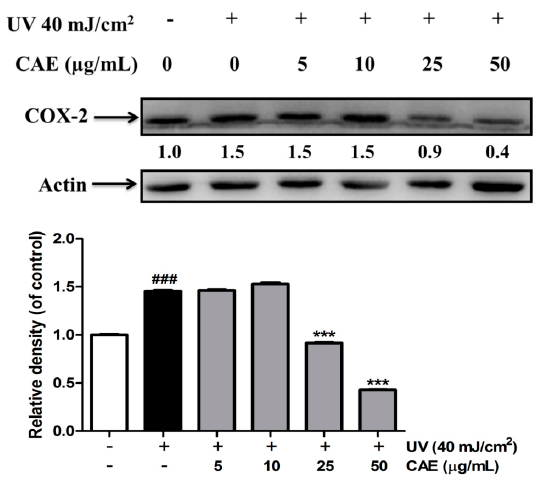
Figure 8. Effects of CAE on UVB-induced COX-2 expression in human skin fibroblasts. Significant difference versus control: ###, p < 0.001; significant difference versus the UVB-induced group: ***, p < 0.001.